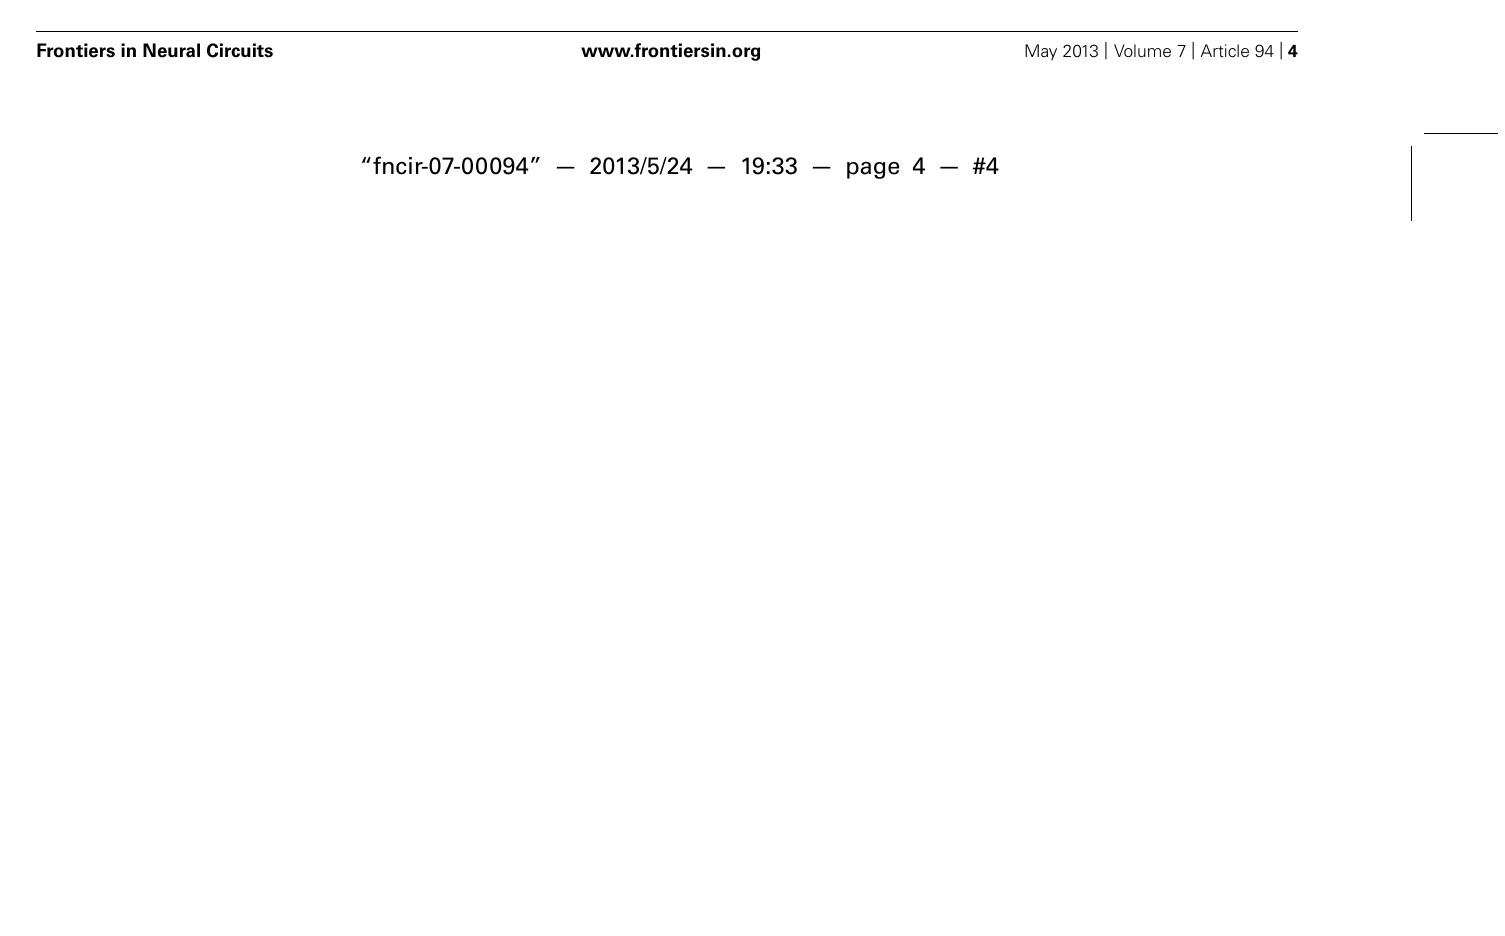
FIGURE 1 | Schematic diagram illustrating possible functions of closed triangle circuit consisting of inferior olive (IO) nucleus, Purkinje cells (PCs), and deep Cerebellar Nucleus (CN). (A) Early stages of learning. (B) Late stages of learning. Purkinje cells inhibit deep cerebellar nucleus cells. Inhibitory deep cerebellar nucleus cells innervate dendrites of inferior olive cells within glomeruli very close to gap junctions.The diagram does not include mossy-fiber inputs and their target granule cells, parallel-fiber inputs,